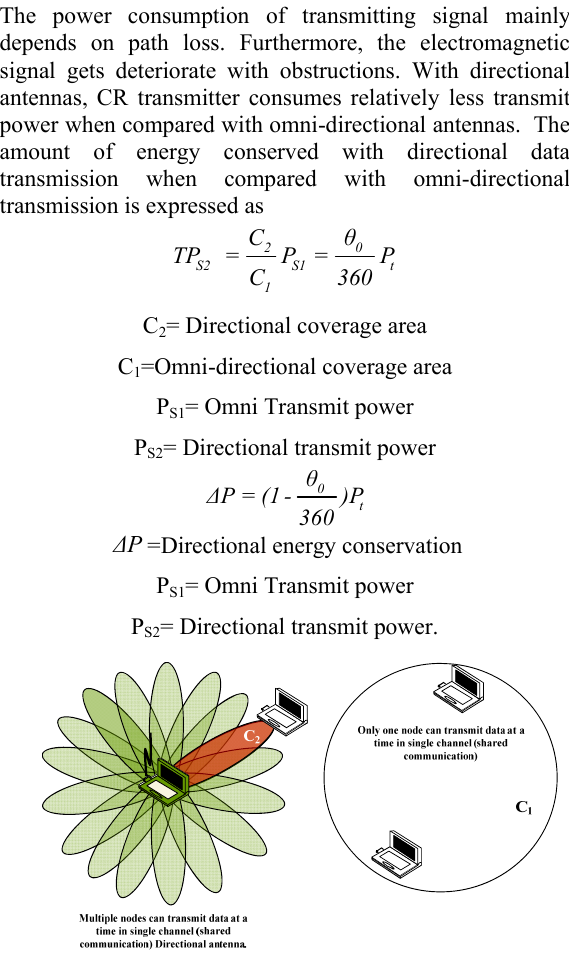
Figure 9. Directional DCF data energy